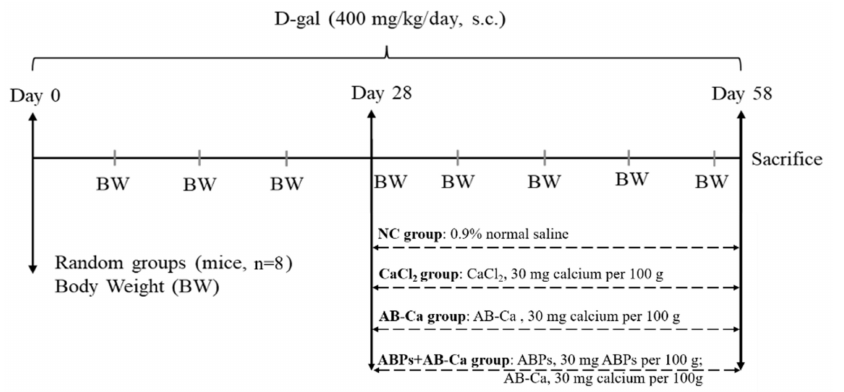
Figure 1. Full animal experimental protocol’s timetable. For 58 days, all groups were administered subcutaneous D-gal (400 mg/kg/day) in the morning. Each group was gavaged with 0.9% saline, CaCl 2 , AB − Ca, and ABPs + AB − Ca daily for 30 days when D-gal was injected for 28 days, and BW was recorded every week. The mice were killed on day